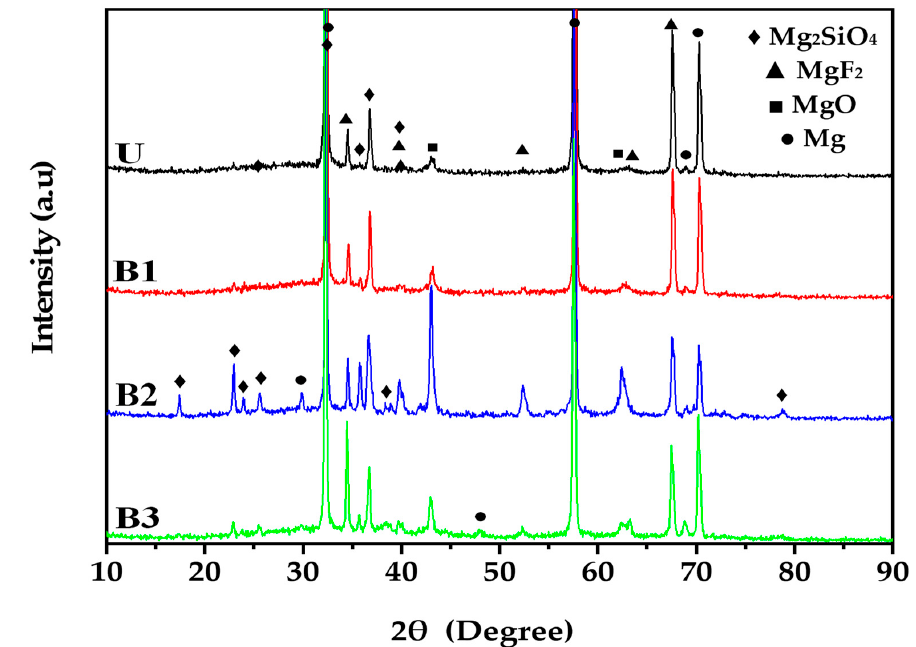
Figure 5. XRD patterns of obtained coatings formed at various waveform of plasma electrolytic oxidation (PEO) process.